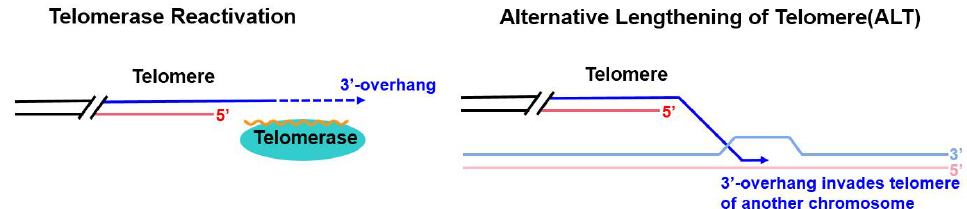
Figure 1. Two distinct telomere extension mechanisms. Left: Through reverse transcriptase activity, telomerase extends the 3 (cid:48) -overhang of telomeres. Right: ALT pathway action depends on homologous recombination (HR) for telomere extension and break-induced replication (BIR), in which the 3 (cid:48) DNA overhang invades homologous double-stranded telomeric DNA of another chromosome, leading to the formation of a DNA displacement loop (D-loop). The invading strand then serves as the primer for the initiation of DNA replication.